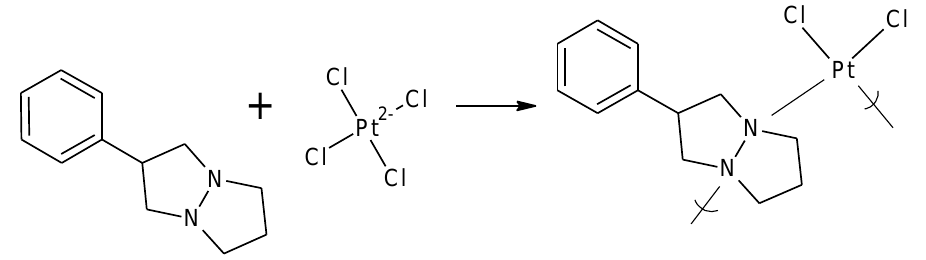
Figure 13. Repeat unit for the polymer obtained from reaction between tetramisole and